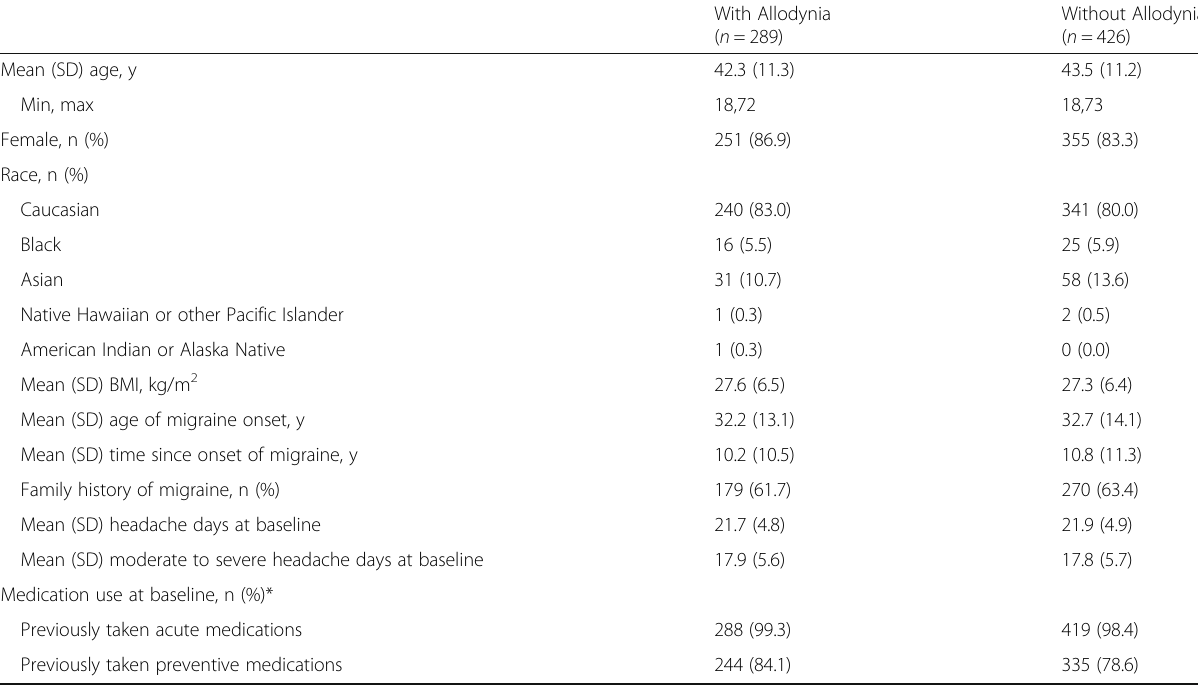
Table 1 Baseline Patient Demographics and Clinical Characteristics of Patients With and Without Allodynia